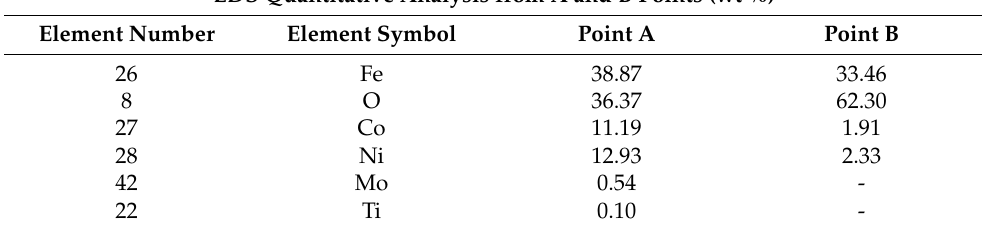
Table 3. Energy-dispersive X-ray spectroscopy (EDS) analysis performed at two different points (as shown in Figure